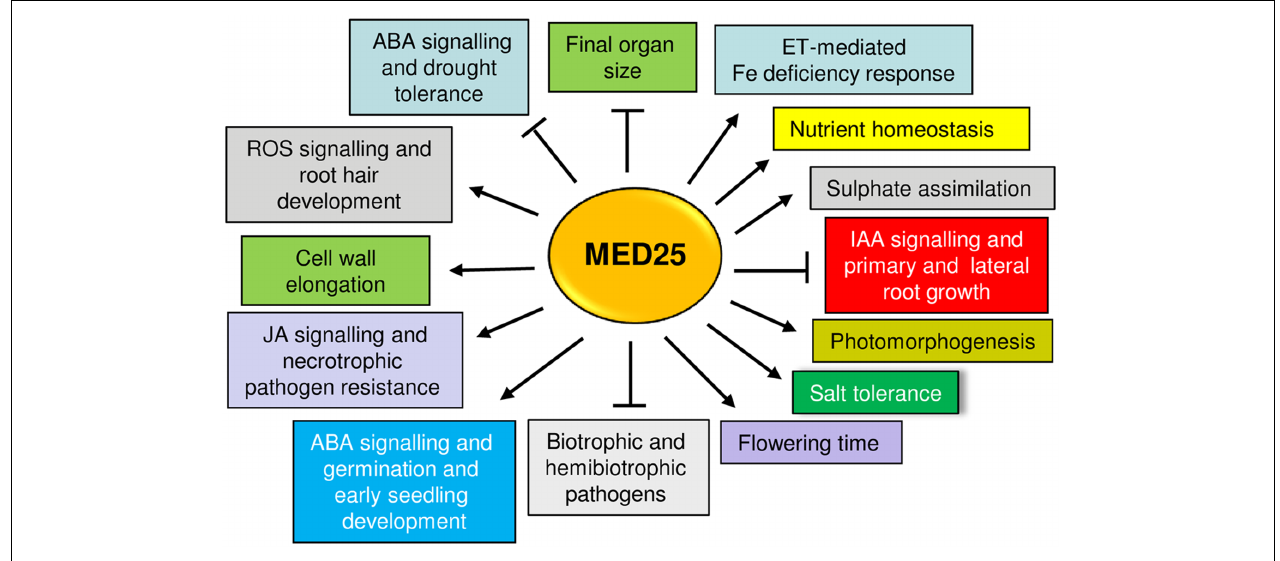
FIGURE 3 | An overview of different plant functions positively (arrows) or negatively (blunt arrows) regulated by MED25. Please see text for details.